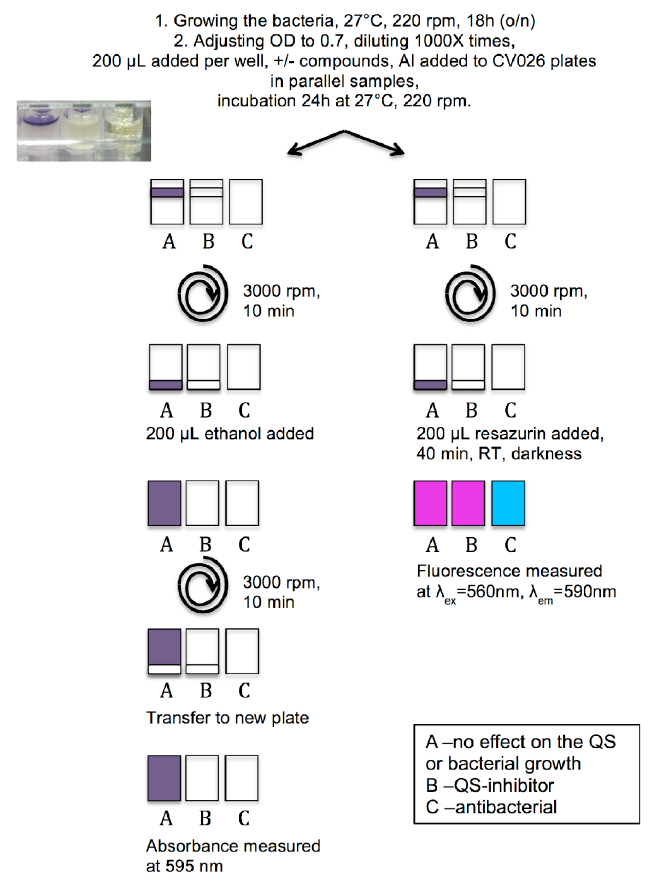
Figure 1. A schematic view of the workflow for the two assays of the platform. Parallel samples are used for violacein extraction (left pathway) and resazurin staining (right pathway). The rounded arrow indicates the centrifugation steps. The insert shows a photograph of the wells with samples of the different effects. From left to right: A represents a control well or a non-active compound, where the QS is active and violacein is produced. B represents an active QS inhibitor, where the violacein production is inhibited but the bacterial growth has not been altered (seen as turbid well). C represents the well of an antibacterial compound, where the bacteria have been completely killed and the medium is clear. AI addition stands for addition of autoinducer, 0.5 μ M C 6 -HSL is used here.